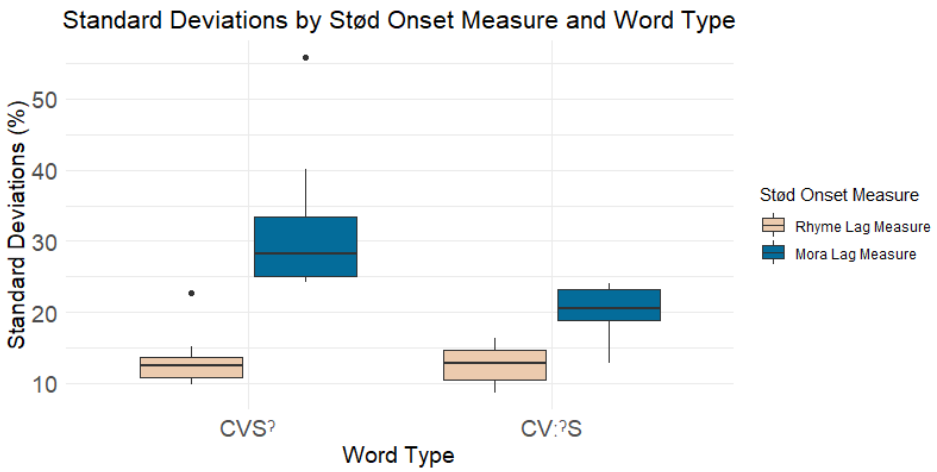
Figure 7. Standard deviations as a percentage of the relevant phonological domain by stød onset measure and word type.